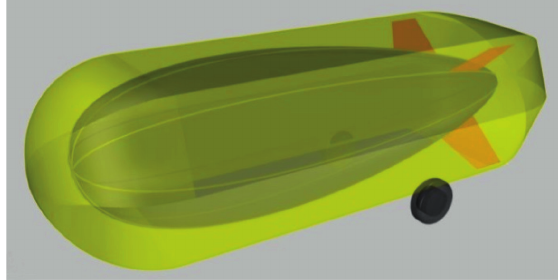
Fig. 2. K28 aerostat, inside the transport system